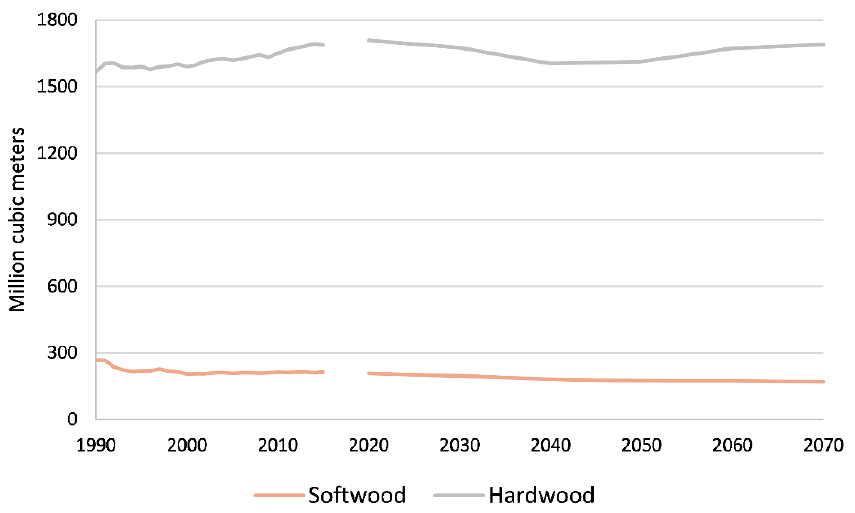
Figure 7. Global production of fuelwood by species type, SSP2, 2012 to 2015 historic, 2020 to 2070 projections from FOROM.